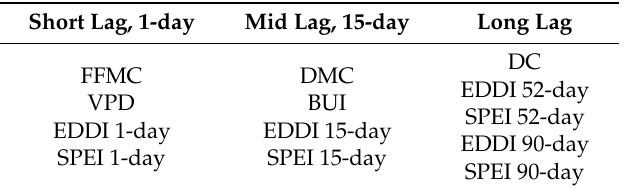
Table 1. List of fire indices and the key timescales of interest for this